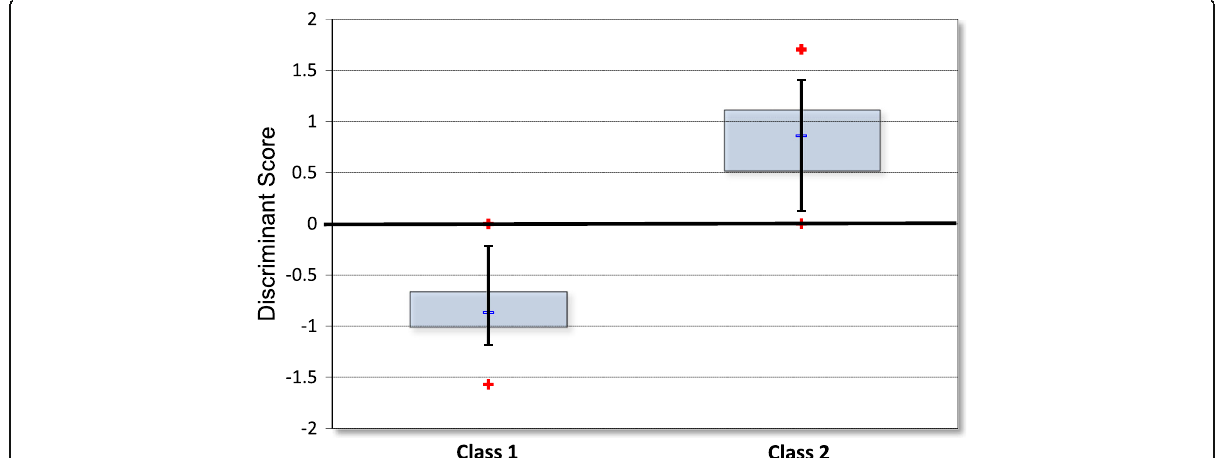
Fig. 5 Distribution of discriminant scores. The distribution of discriminant scores that have been reported clinically. The output of the SVM algorithm is negative for Class 1, but reported as a positive number. The 50th percentile is represented by the blue box and the black bars indicate the 90th percentile. The blue line is the median of each group and the red stars indicate the minimum and maximum observed scores of each Class